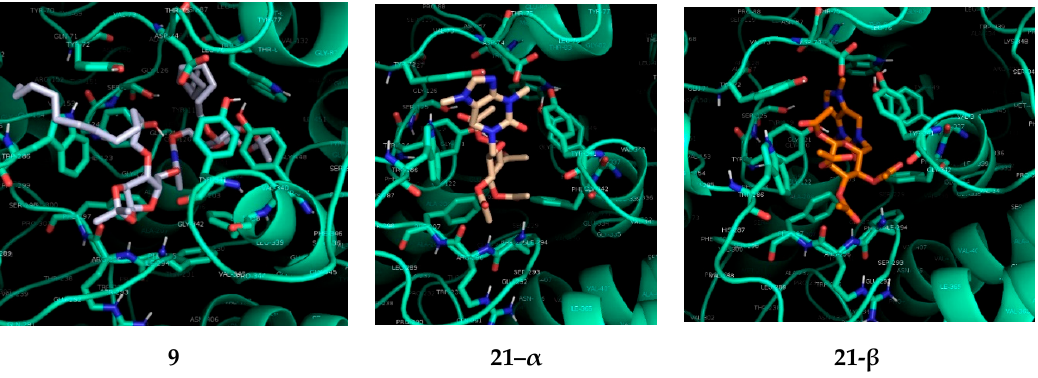
Figure 4. Binding energies (kcal / mol) of the top docking poses of compounds 9 , 21- α and 21- β into AChE and BChE.